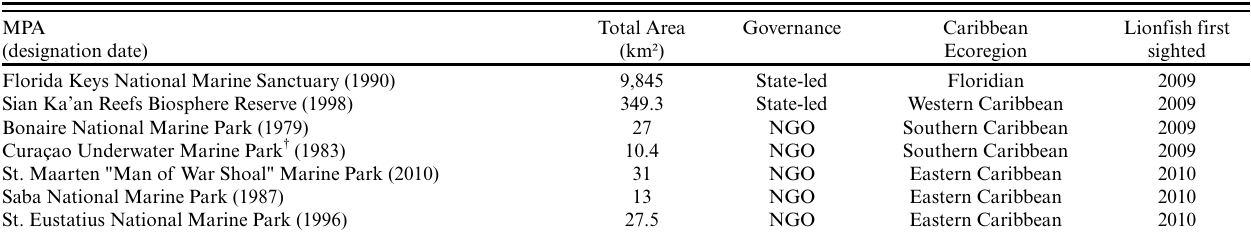
Table 1 . Selected marine protected areas. Data from MPA Global (http://www.mpaglobal.org/) and MPAtlas (http://www.mpatlas.org/); ecoregions after Spalding et al.